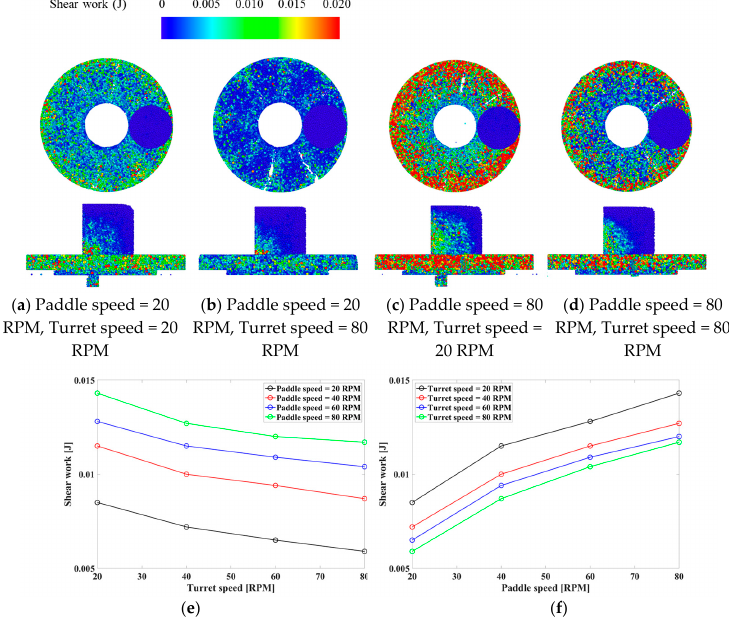
Figure 9. Image showing the top view and the side view of the spatial distribution of particle distance traveled at a given time instance (30 s) for four different operating conditions ( a – d ) and mean shear work done at different operating conditions ( e , f ) at a given time instance (30 s). ( a ) Paddle speed 20 RPM and turret speed 20 RPM; ( b ) Paddle speed 20 RPM and turret speed 80 RPM; ( c ) Paddle speed 80 RPM and turret speed 20 RPM; ( d ) Paddle speed 80 RPM and turret speed 80 RPM; ( e ) mean shear work varying with turret speed for different paddle speeds; ( f ) mean shear work varying with paddle speed for different turret speeds.